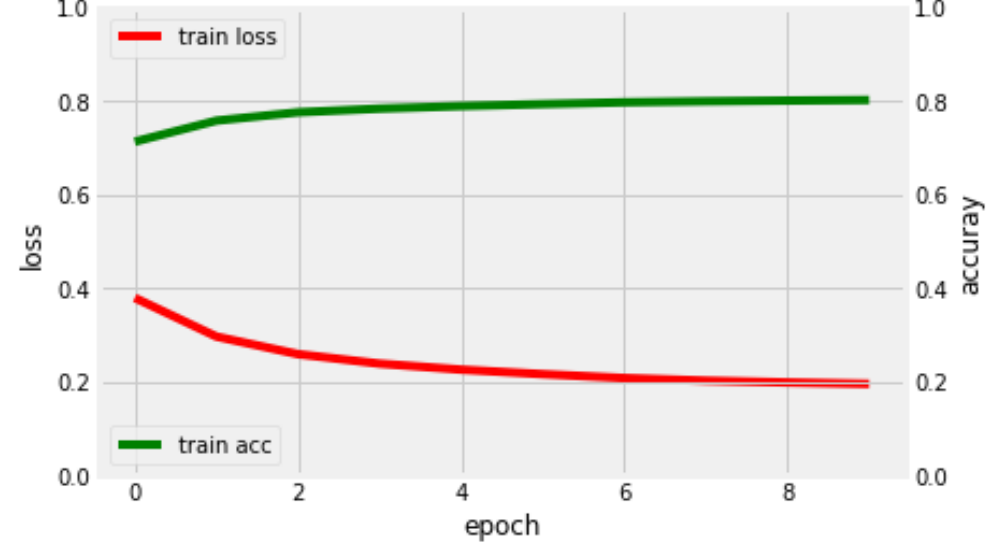
Figure 8. N-gram model training accuracy and